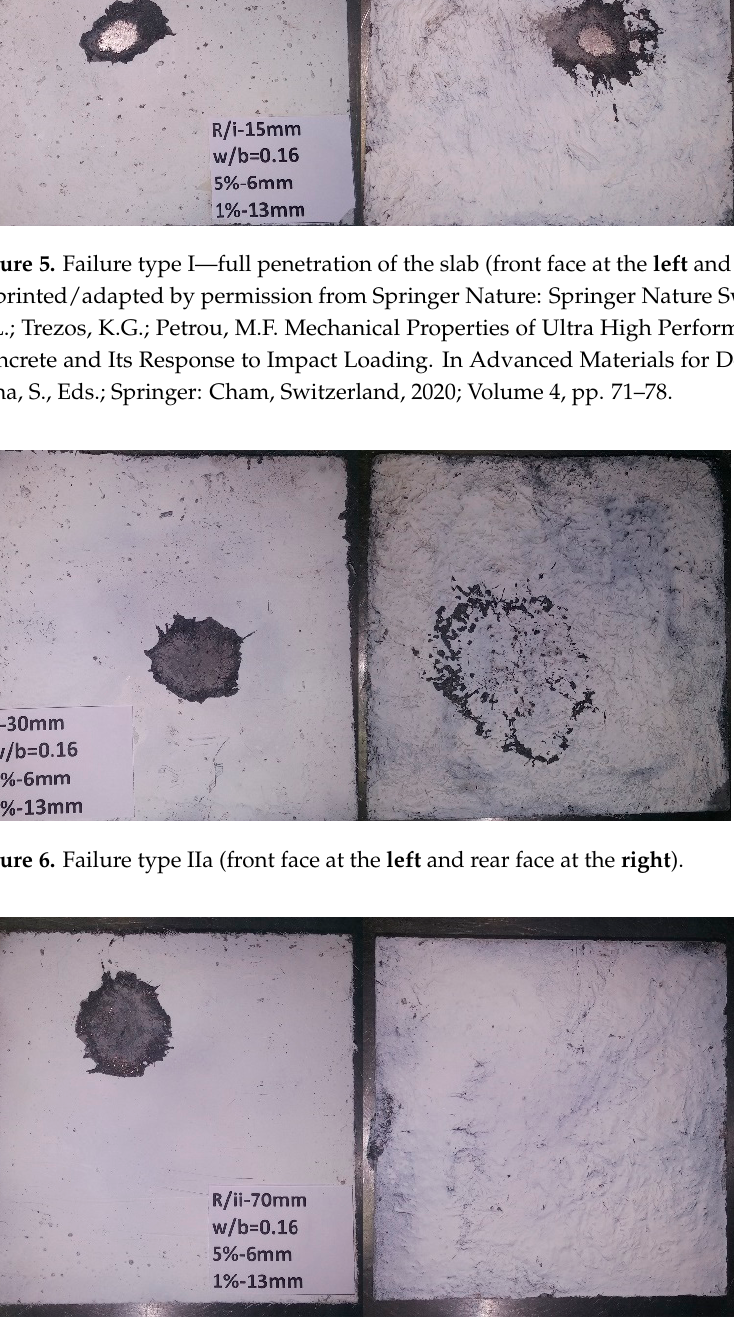
Figure 8. Failure type III. Reprinted/adapted by permission from Springer Nature: Springer Na- ture Switzerland AG, Mina, A.L.; Trezos, K.G.; Petrou, M.F. Mechanical Properties of Ultra High Performance Fibre Reiforced Concrete and Its Response to Impact Loading. In Advanced Materials for Defense; Fangueiro, R.; Rana, S., Eds.; Springer: Cham, Switzerland, 2020; Volume 4, pp. 71–78. After the projectile impact, the damage in the slabs was categorized based on the above three types of failure, as shown in Figures 5–8. Penetration depth, material volume loss, and crater diameter were measured for each tested slab. Material volume loss was measured by filling the crater area with fine sand, the crater diameter was estimated as the average of four measurements, and the penetration depth by measuring the distance between the surface of the slab and the deepest point.